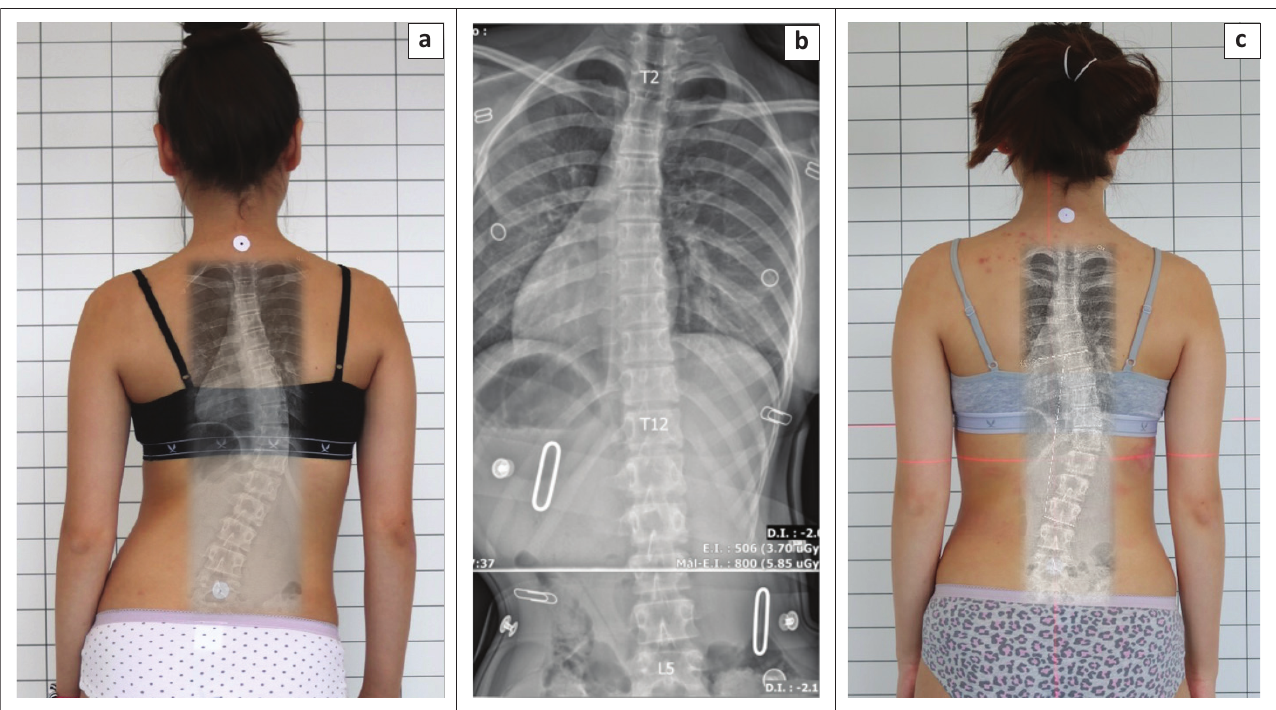
FIGURE 9: (a) This patient at first was treated with a Providence brace and progressed from 31° to 41° within 6 months before switching to a computer aided design Chêneau brace. (b) In the Chêneau brace, the 41° curve was fully corrected. (c) After 8 months, the compliant patient reduced the curve to 29° and showed improved trunk